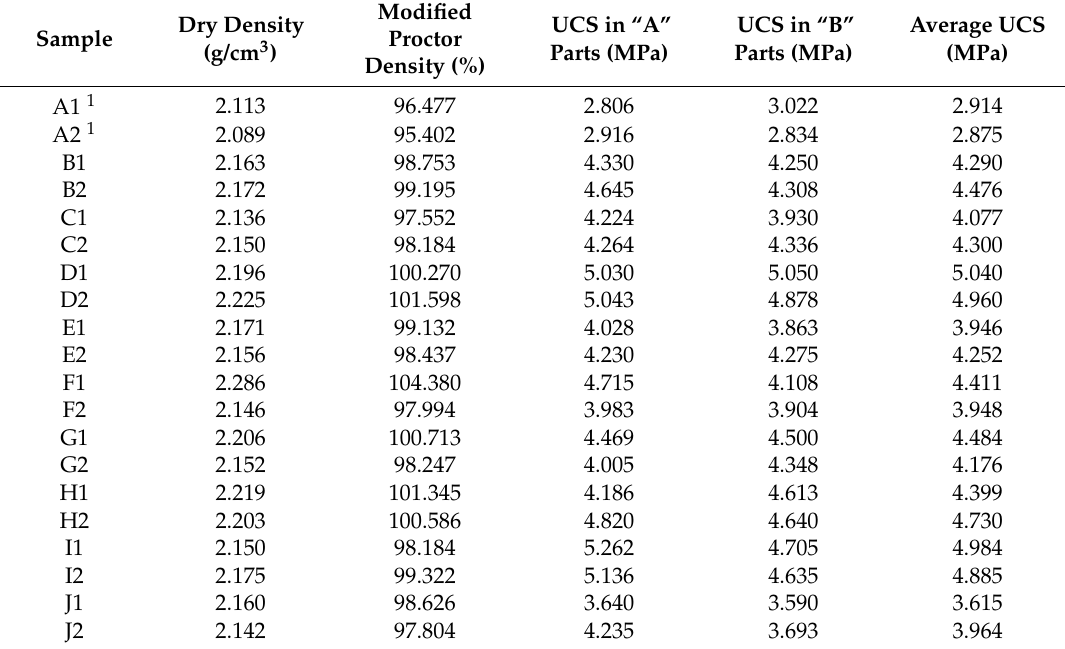
Table 7. Long-term UCS test results on resulting prismatic